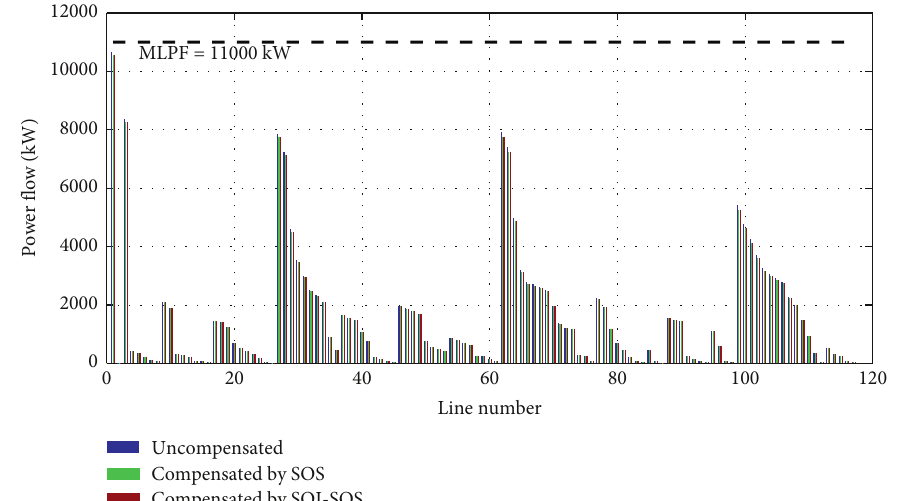
Figure 18: Comparison of lines power flow of the 119-bus system before and after compensation with the CP load model at 100%